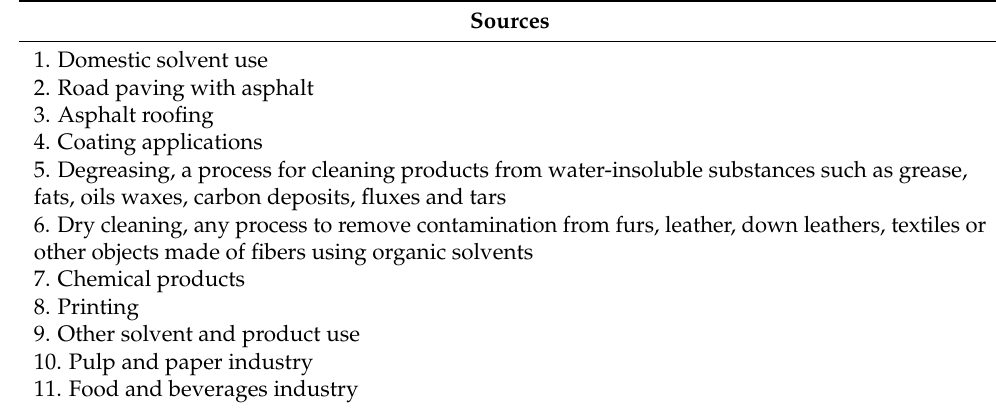
Table 1. Categorization of sources of NMVOCs emissions from solvents.